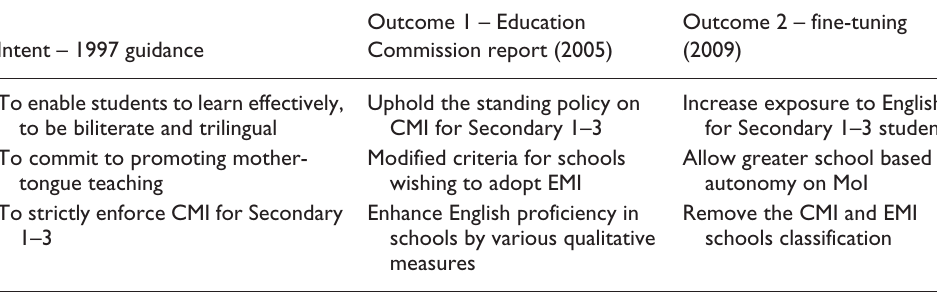
Table 2. Comparison of three policy